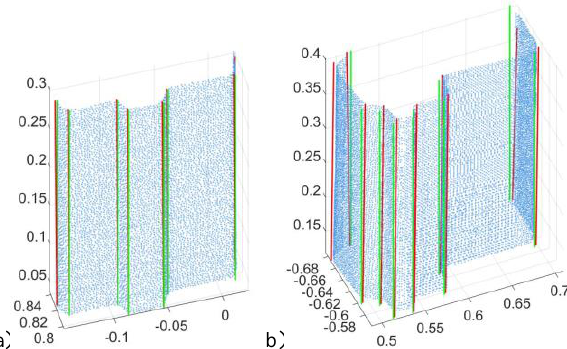
Figure 10. Kinect dense point clouds with computed edges (red) and edges with corrected vertical direction